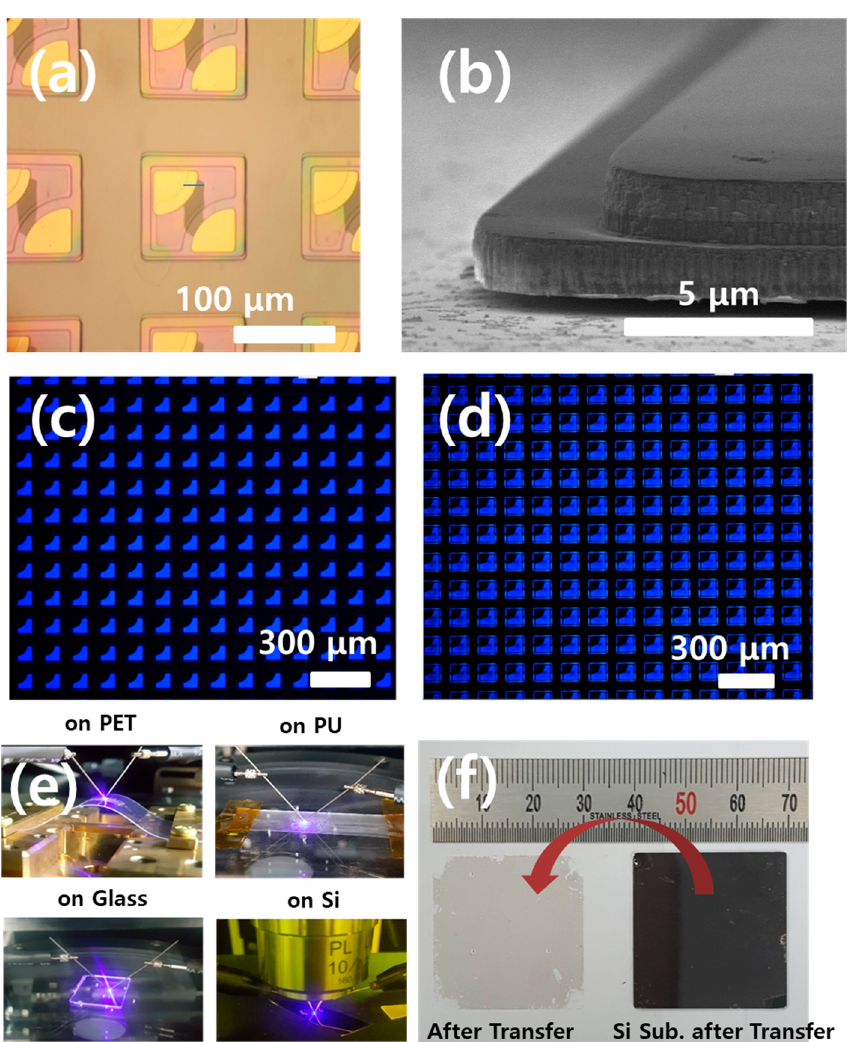
Figure 2. ( a ) Optical microscope image of GaN LED array with vertical tethers. ( b ) FE-SEM image of a GaN LED with a spontaneously formed vertical tether. PL mapping image of GaN LED ( c ) before transfer and ( d ) after transfer ( e ) Images of light emission from GaN LEDs transferred onto various substrates. FE-SEM image of GaN LEDs on a silicon substrate after transfer. ( f ) Optical microscope image of a GaN LED array (3 × 3 cm 2 ) on a glass substrate after transfer.